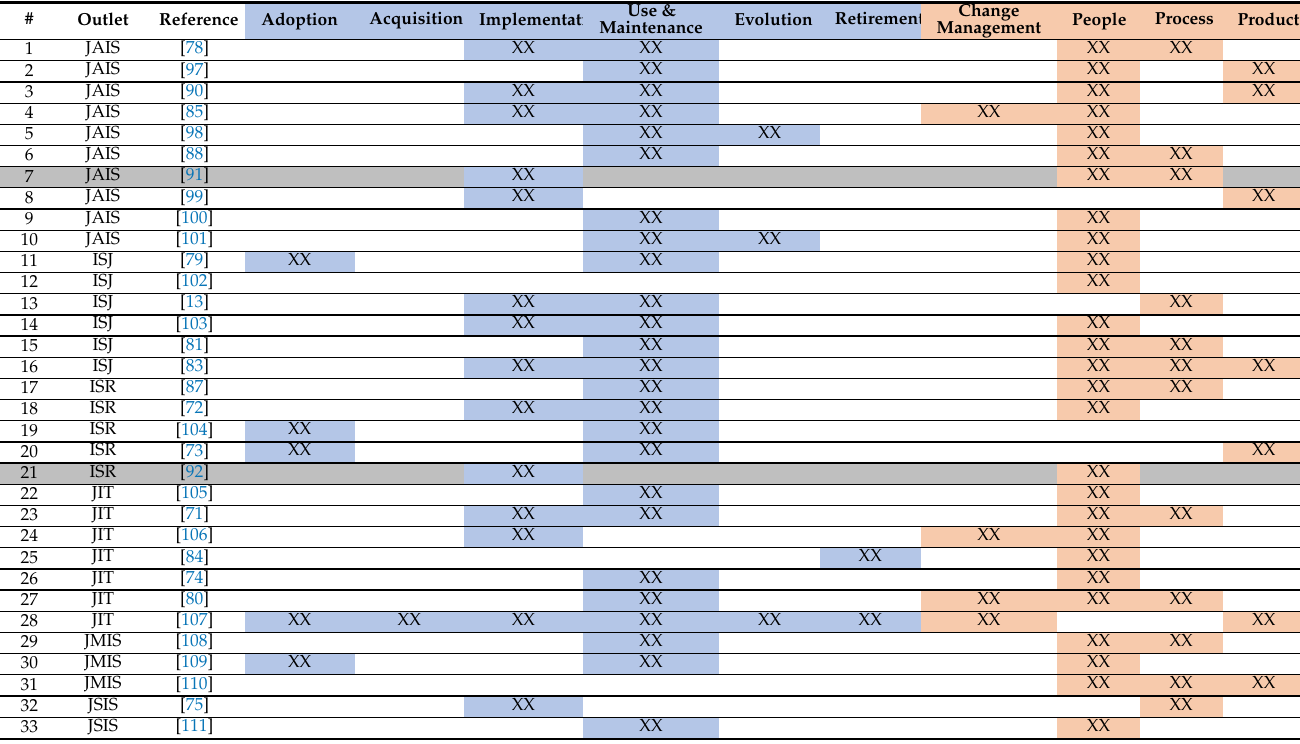
Table 1. The included/cited journal articles and the corresponding topic focus across the ESs implementation lifecycle phases (highlighted in blue) XX and dimensions (highlighted in orange) marked in XX. It is to be noted that rows showing search hits coinciding between {“enterprise systems” + challenges} and {“enterprise systems” + “deep learning”} are highlighted in